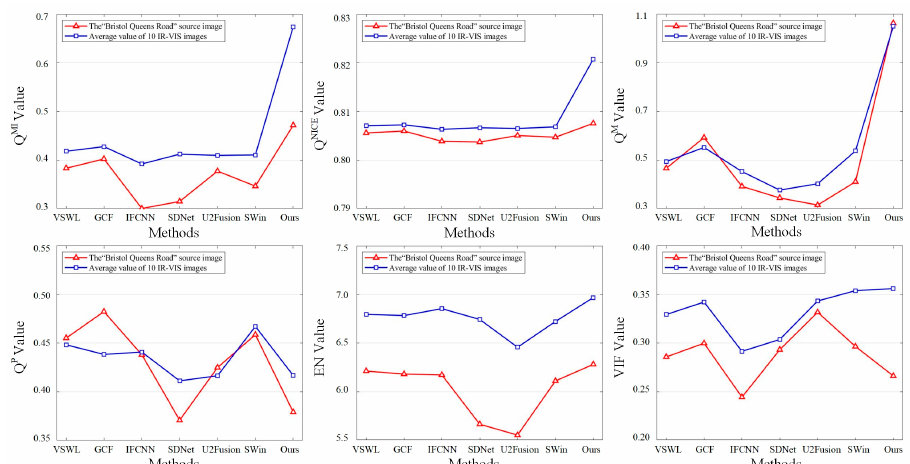
Figure 10. Objective evaluation of 7 methods on IR-VIS image